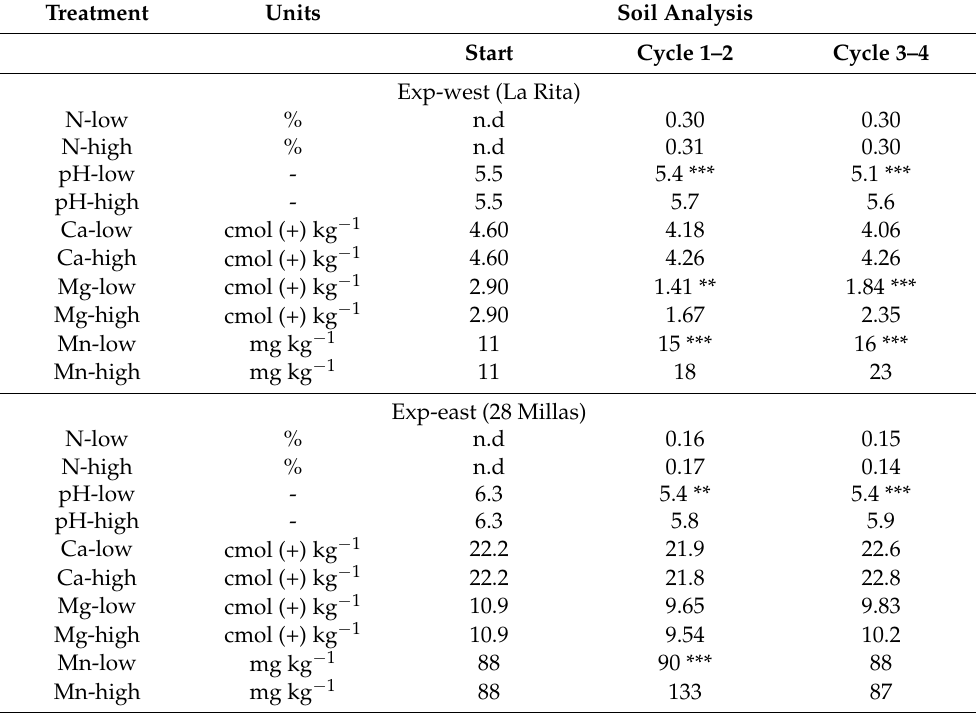
Table 2. Soil chemical properties in two experiments (Exp-west and Exp-east) from two locations (La Rita and 28 Millas respectively) of the Costa Rican banana region during the experimental period of four crop cycles. ( n = 32 per soil chemical property in each region and crop cycle).